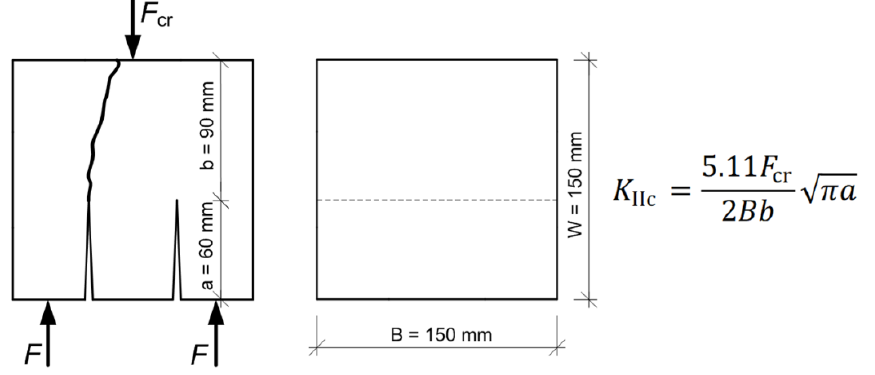
Figure 4. Detail of specimen used in the studies.